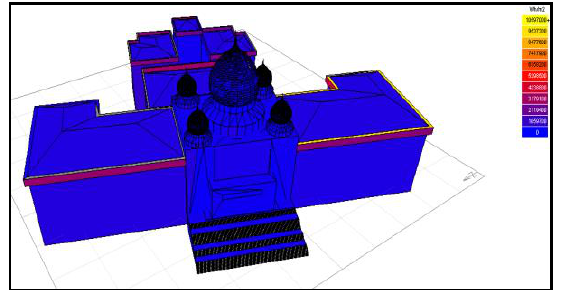
Figure 7. Information of total absorbed radiation generate from